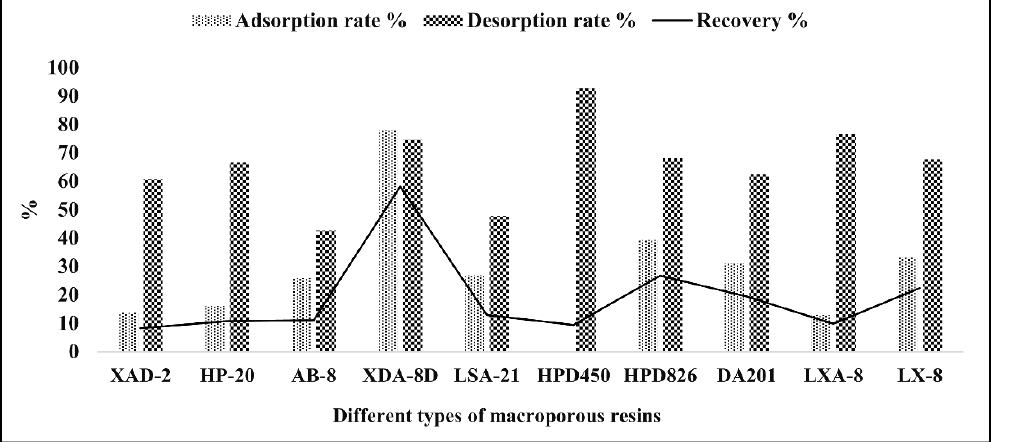
Figure 4. Effect of resin type on the static adsorption and desorption of ellagic